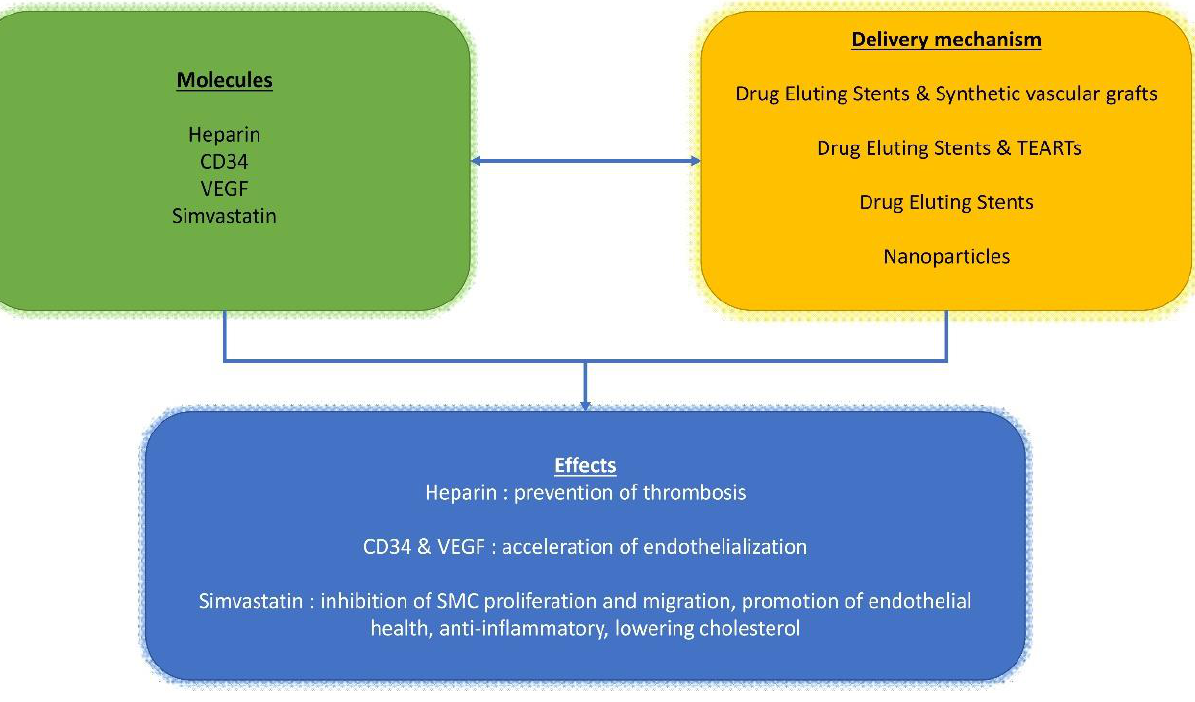
Figure 2. Schematic representation of different pathways described in the text. Effect of heparin, CD34, VEGF and simvastatin (green box) and their delivery mechanisms (yellow box) and downstream effects (blue box).